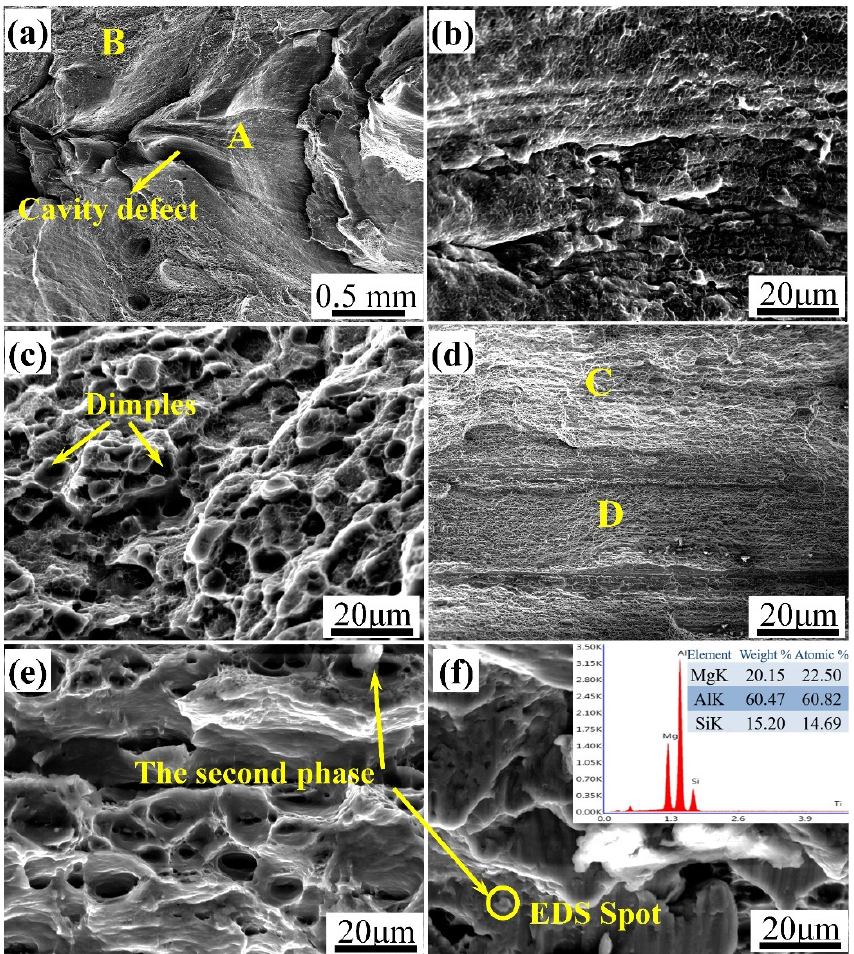
Figure 12. SEM micrographs showing fracture surfaces of the joints: ( a ) the macro-morphology at low magnification at the welding speed of 350 mm/min; ( b ) high magnification images of region A; ( c ) high magnification images of region B; ( d ) the macro-morphology at low magnification at the welding speed of 450 mm/min; ( e ) high magnification images of region C; ( f ) high magnification images of region D and EDS of the precipitated particles.